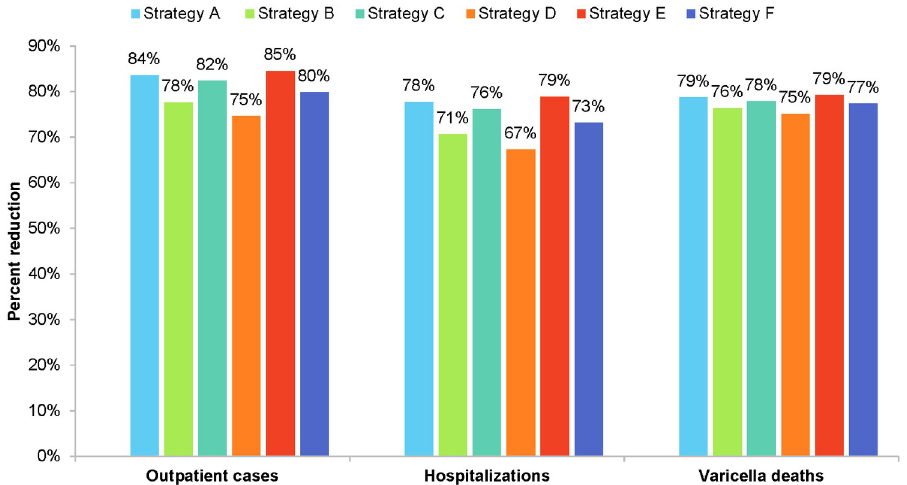
Fig 4. Projected impact of universal varicella vaccination on varicella primary care cases, hospitalizations, and deaths.